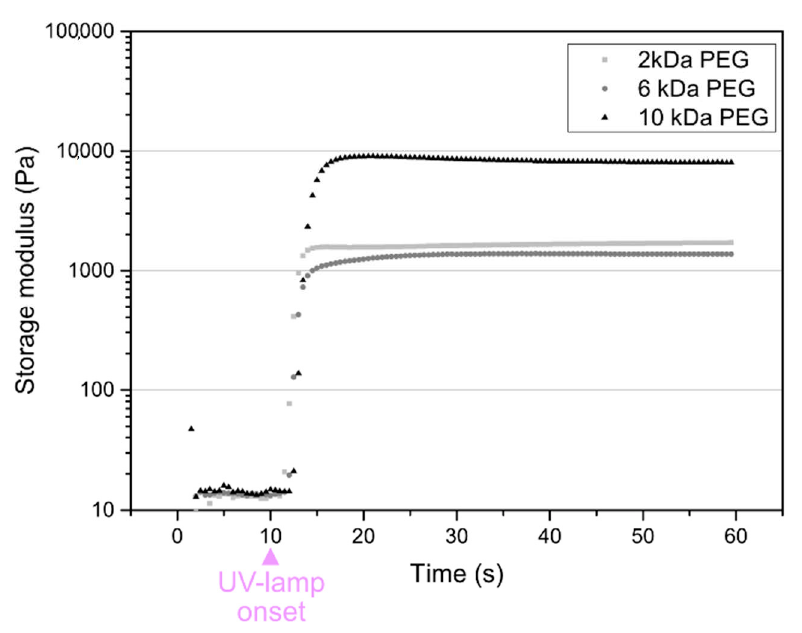
Figure 2. Hydrogels were cured on a circular rheometer geometry equipped with a UV-lamp while monitoring the modulus. The storage modulus stabilized within seconds of the onset of the UV-lamp and the highest modulus after curing was recorded for the 10 kDa gels.